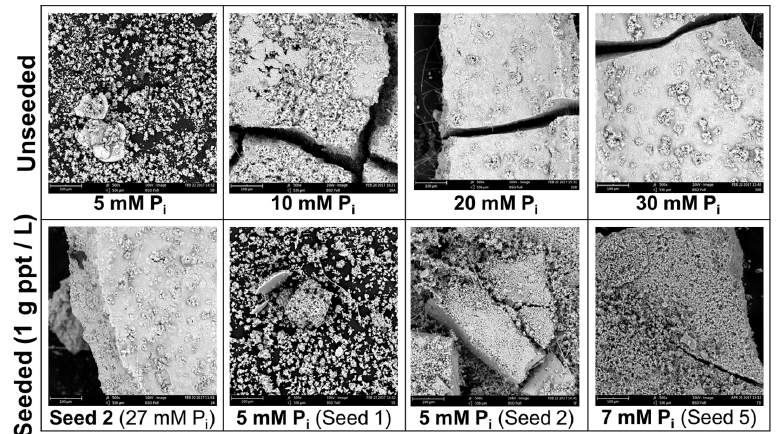
Figure A1. SEM images of precipitates from unseeded and seeded experiments, with the corresponding initial [Pi] used to produce the precipitate when mixed with saturated Ca-CO 3 solutions.